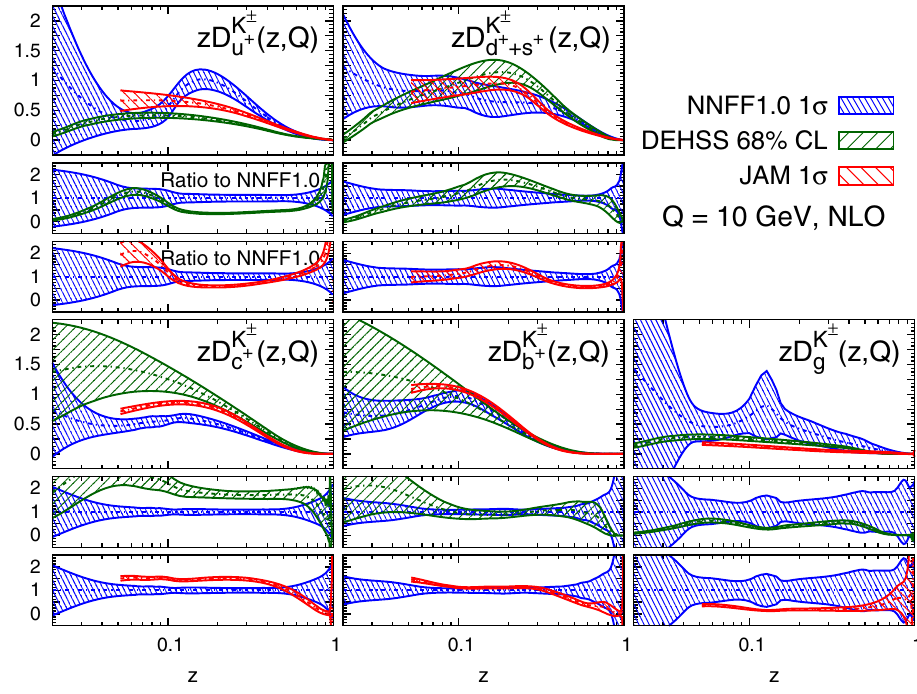
Fig. 13 Same as Fig. 12, but for the sum of charged kaons, K